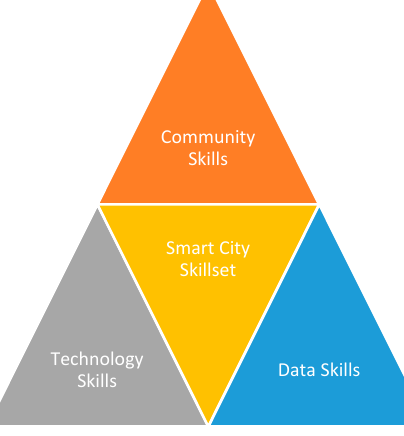
Figure 3. Model of needed smart city skills.